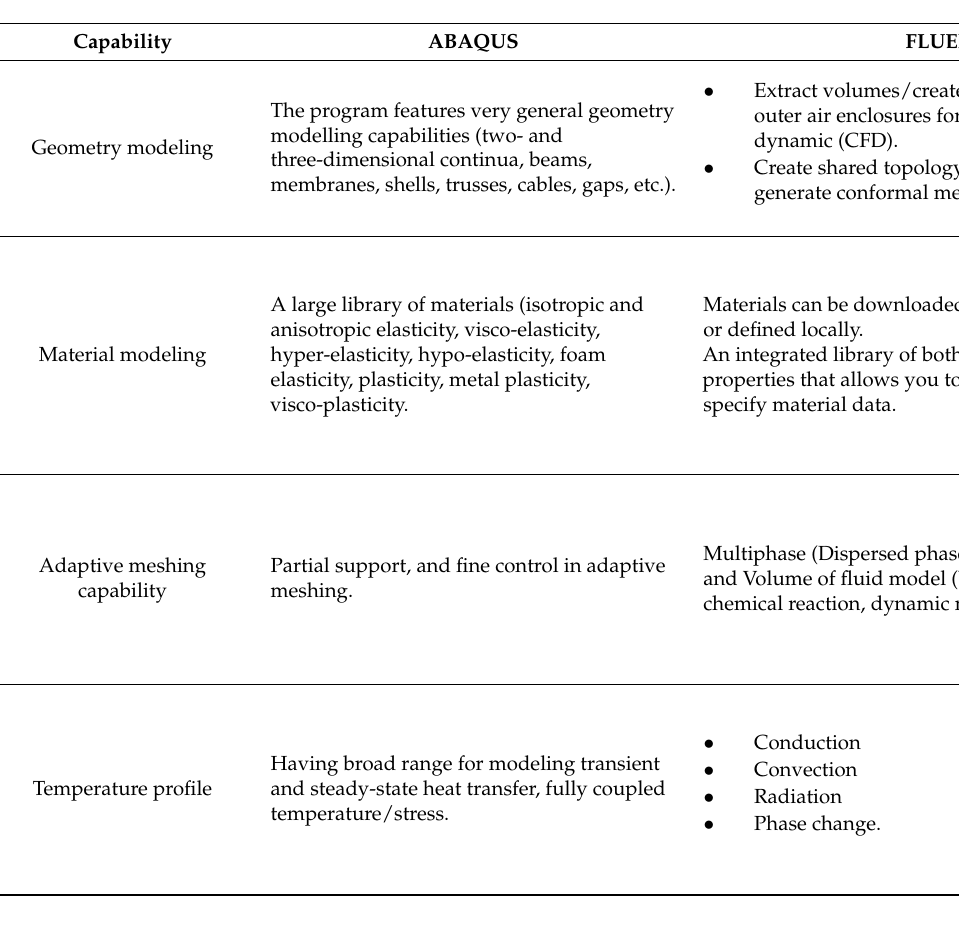
Table 1. Different software packages